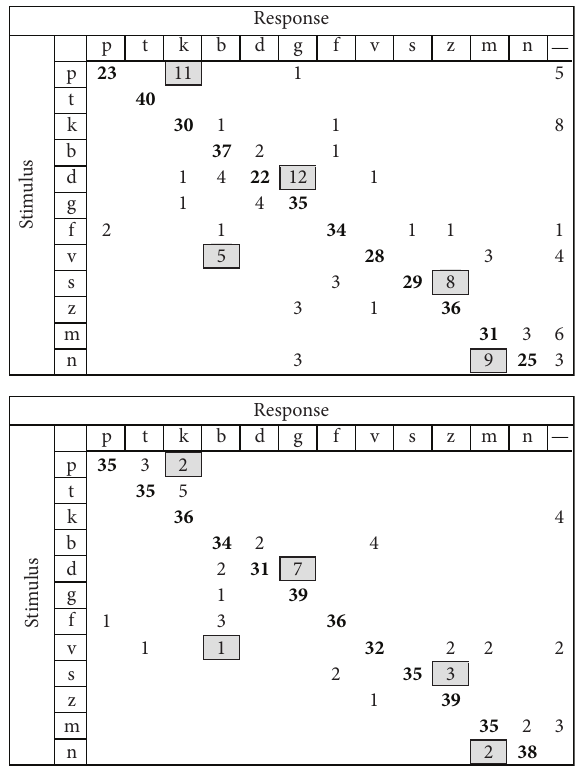
Figure 7: Confusion matrix for Interval group. Baseline is on top, posttraining at the bottom. Significant confusions in baseline have been marked in grey, and this is carried over to the posttraining matrix for easier visual identification of confusion decreases.